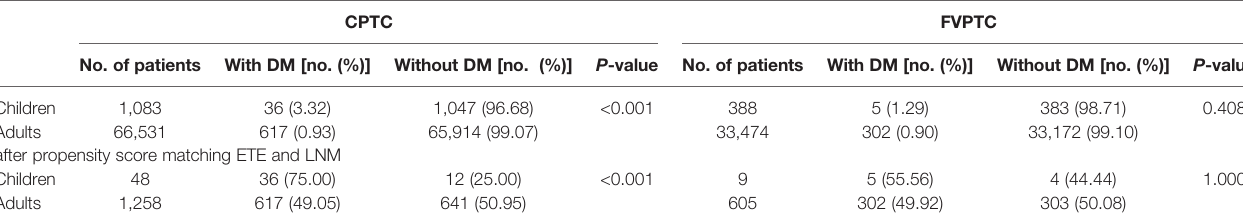
TABLE 3 | Comparison of children and adults with distant metastasis in CPTC and FVPTC. CPTC FVPTC No. of patients With DM [no. (%)] Without DM [no. (%)] P -value No. of patients With DM [no. (%)] Without DM [no. (%)] P